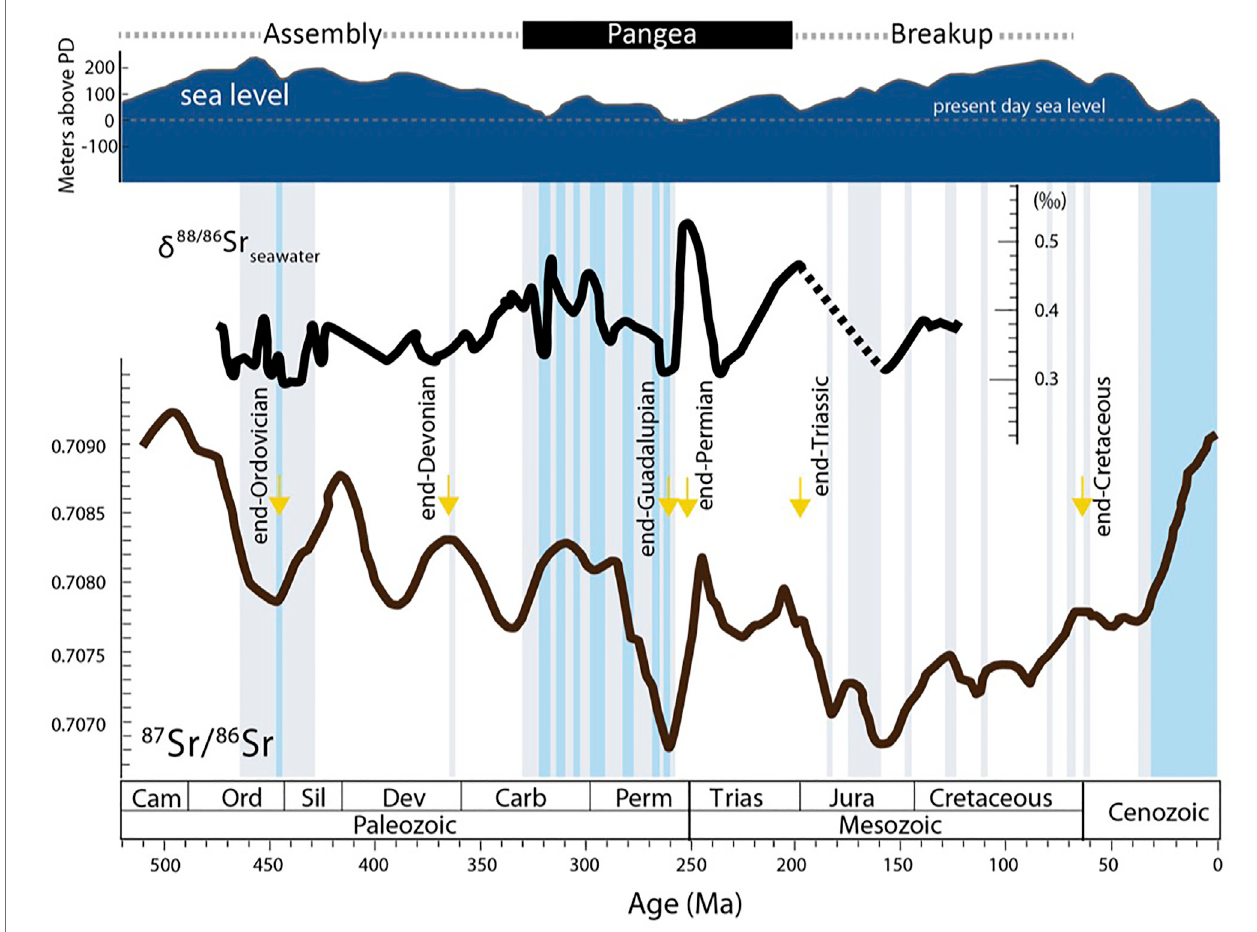
FIGURE 1 | Overview of Phanerozoic seawater 87 Sr/ 86 Sr and δ 88 Sr pro fi les with major extinction timings, secular changes in sea level, glacial episodes and the assembly and breakup of the supercontinent Pangea. 87 Sr/ 86 Sr and δ 88 Sr pro fi les are modi fi ed from McArthur et al. (2012) and Vollstaedt et al. (2014). The secular change in sea level is modi fi ed from Haq and Schutter (2008). Vertical light gray and blue bars represent are cold and glacial episodes, respectively (Dera et al., 2011; Friedrich et al., 2012; Montanez and Poulsen, 2013; Bodin et al., 2015; Montanez, 2016; Fielding et al., 2008; Metcalfe et al., 2015).